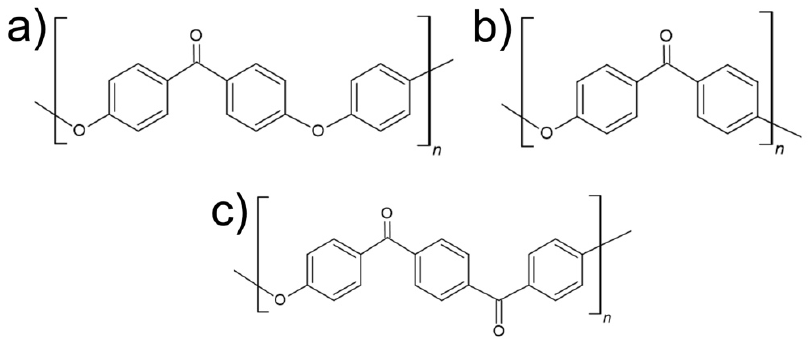
Figure 1. Chemical structures of ( a ) PEEK—Polyetheretherketone, ( b ) PEK—Polyetherketone and ( c ) PEKK—Polyetherketoneketone .